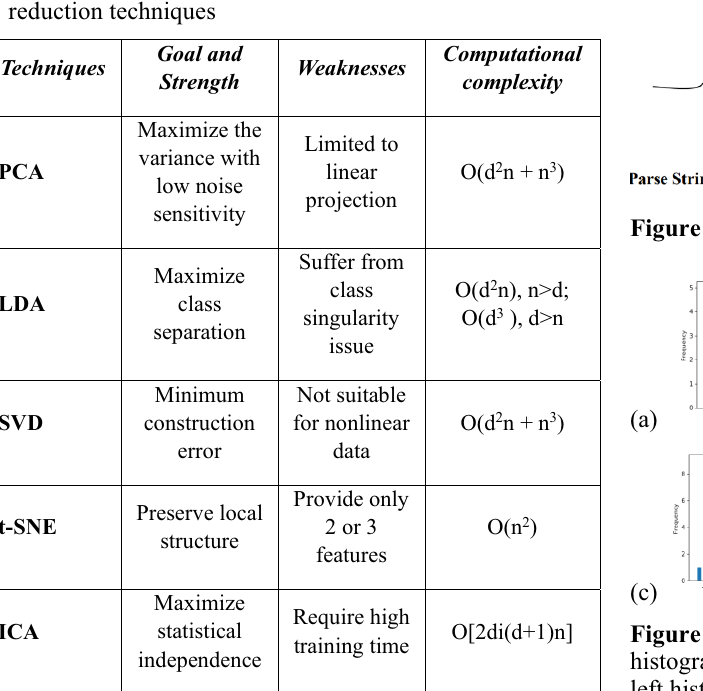
Table 1. Conceptual comparison of dimensionality